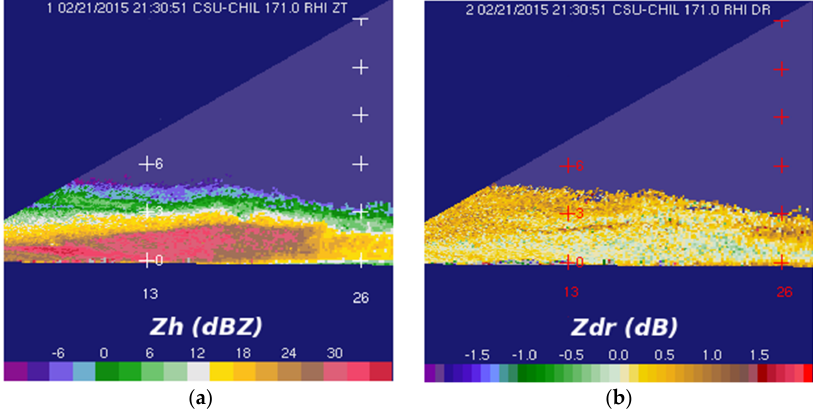
Figure 25. CSU-CHILL radar RHI scan over the MASCRAD Easton site (located at a range of 12.92 km) at ~21:31 UTC on 21 February 2015. ( a ) Maximum reflectivities slightly exceeded 30 dBZ; ( b ) Differential reflectivities were near 0 dB in the high reflectivity regions.